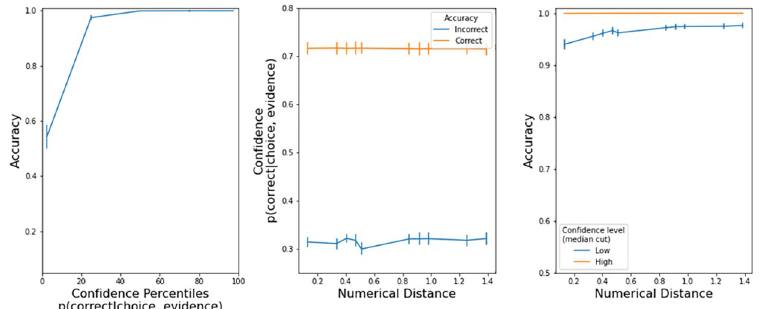
Fig 8. Confidence properties in the drift diffusion model (Exp 2). Left panels: accuracy increased with more confidence. Center panels: there was low confidence in incorrect trials. Right panels: accuracy is higher in high confidence trials. Error bars are s.e.m.